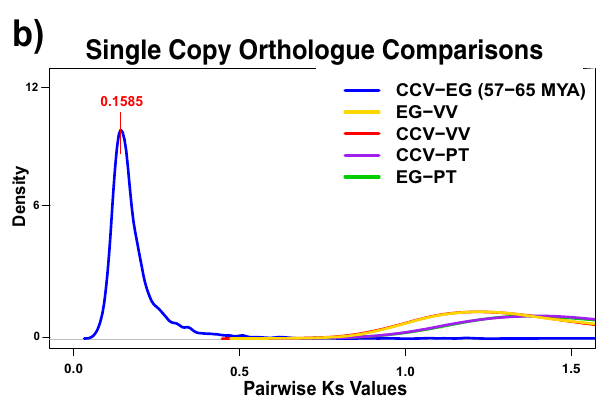
Fig. 2 Orthologous gene groups among woody plant genomes. a Shared orthogroups among Corymbia citriodora ssp. variegata , Eucalyptus grandis , Populus trichocarpa , Salix purpurea, and Vitis vinifera . b Single-copy ortholog synonymous substitution rate (Ks) comparisons to date the Corymbia / Eucalyptus divergence. Blue line- Synonymous substitution rates among CCV and EG orthologs. Yellow line- Synonymous substitution rates among EG and VV orthologs. Red line- Synonymous substitution rates among CCV and VV orthologs. Purple line- Synonymous substitution rates among CCV and PT orthologs. Green line- Synonymous substitution rates among EG and PT orthologs. PT Populus trichocarpa , CCV